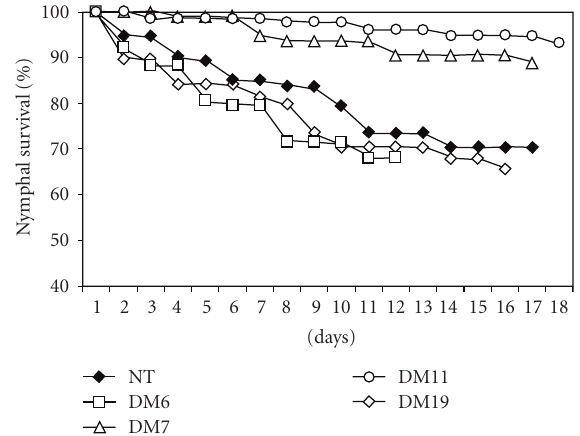
Figure 2: Nymphal survival (%) of Myzus persicae reared on nontransformed (NT) and selected DM